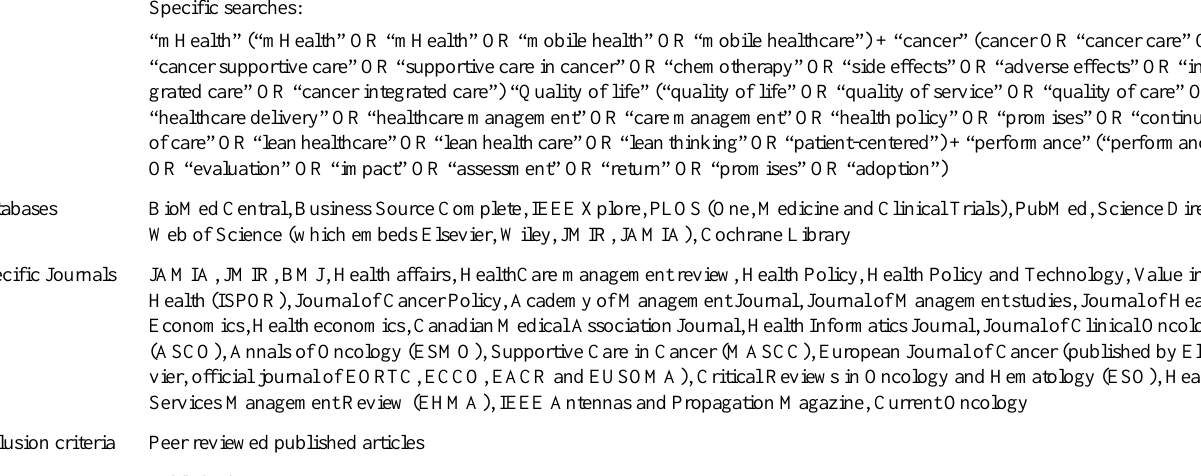
Table 1. Research strategy. Generic search using the concept words: “mHealth”, “cancer”, “quality of life”Keywords Specific